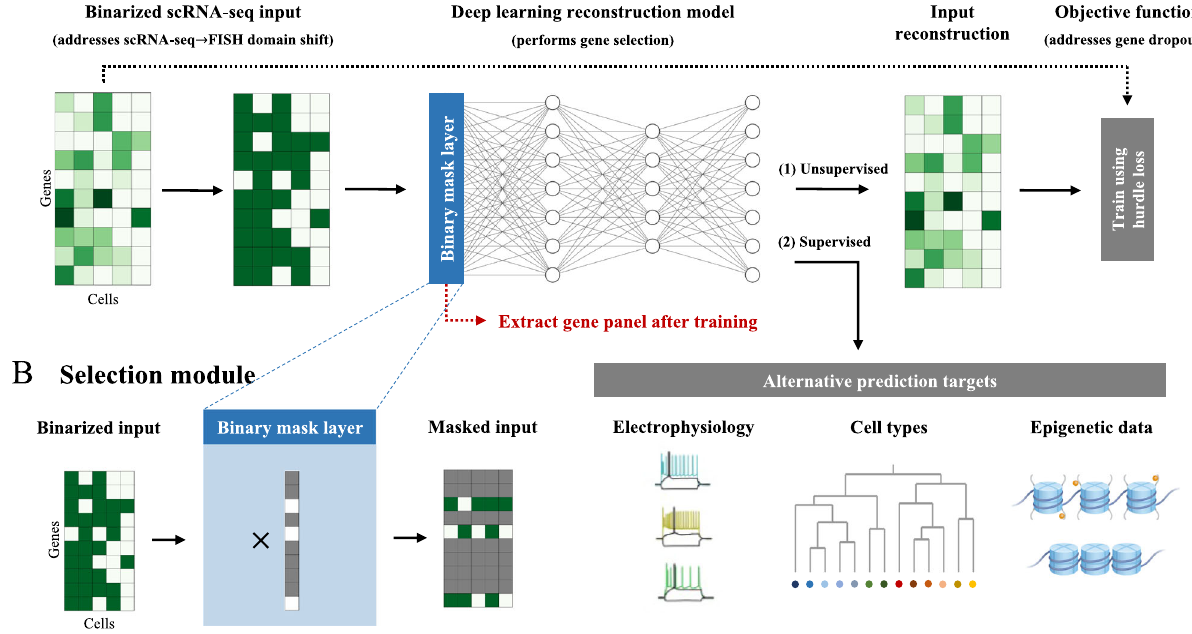
Fig. 1 | Overview of predictive and robust gene selection for spatial tran- scriptomics (PERSIST). PERSISTselectsgenesusing a deep learningmodeltrained to reconstruct the genome-wide expression pro fi le. A The model is trained using scRNA-seq data, which is binarized to address the domain shift relative to FISH measurements. The model by default aims to reconstruct the original scRNA-seq gene expression levels, and the objective function is a hurdle loss designed to